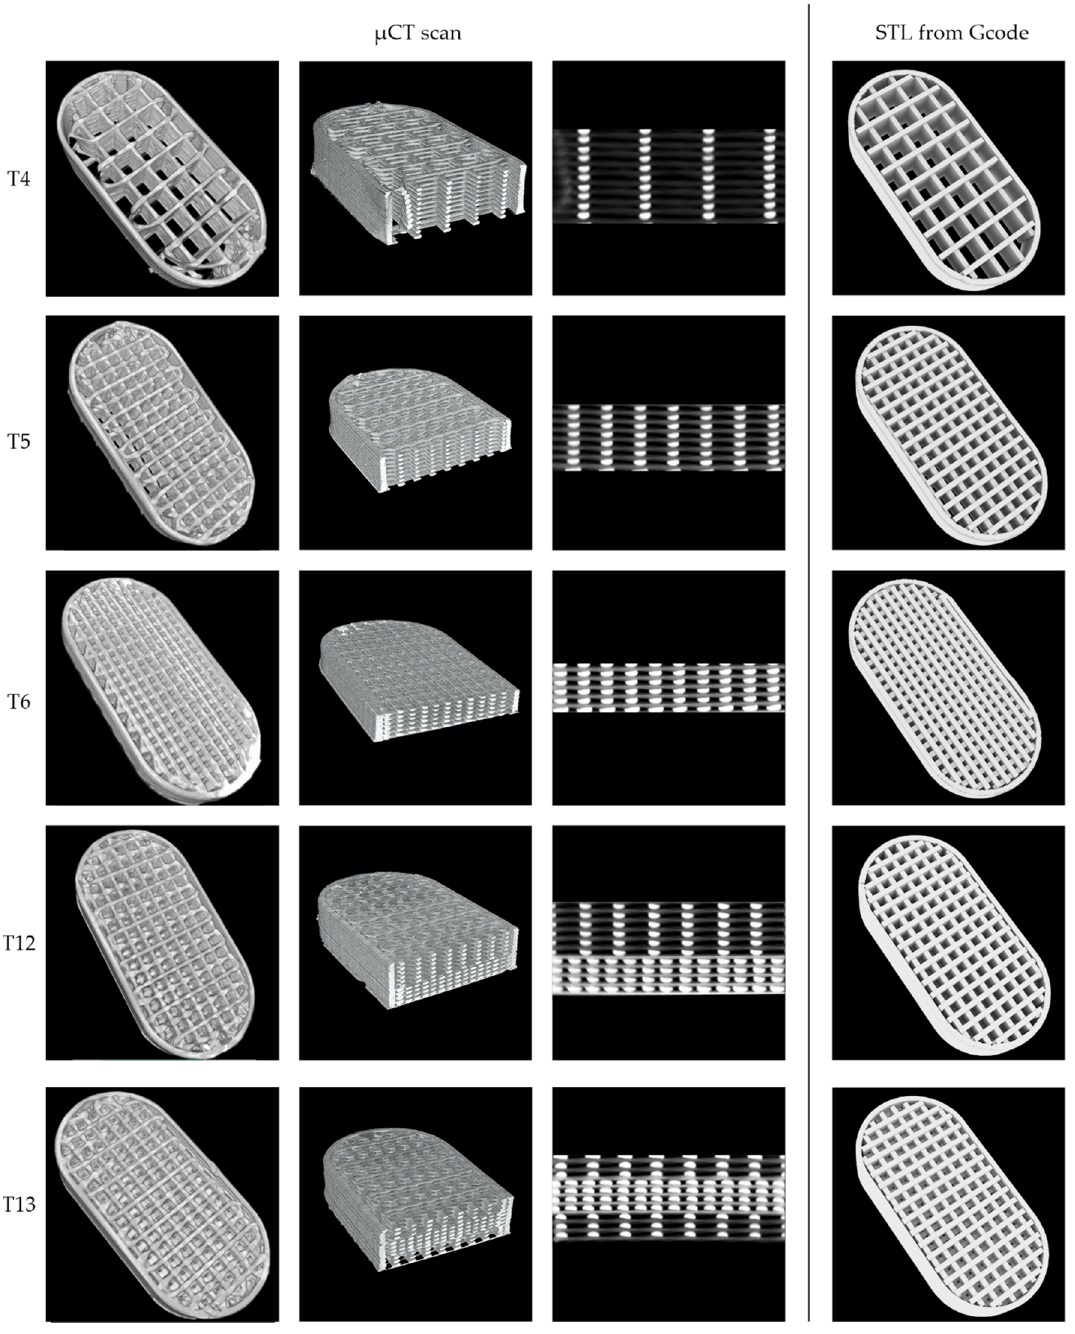
Figure 8. MicroCT scans and 3D design of the single-layer (T4, T5, T6), bilayer (T12), and trilayer (T13) tablets.